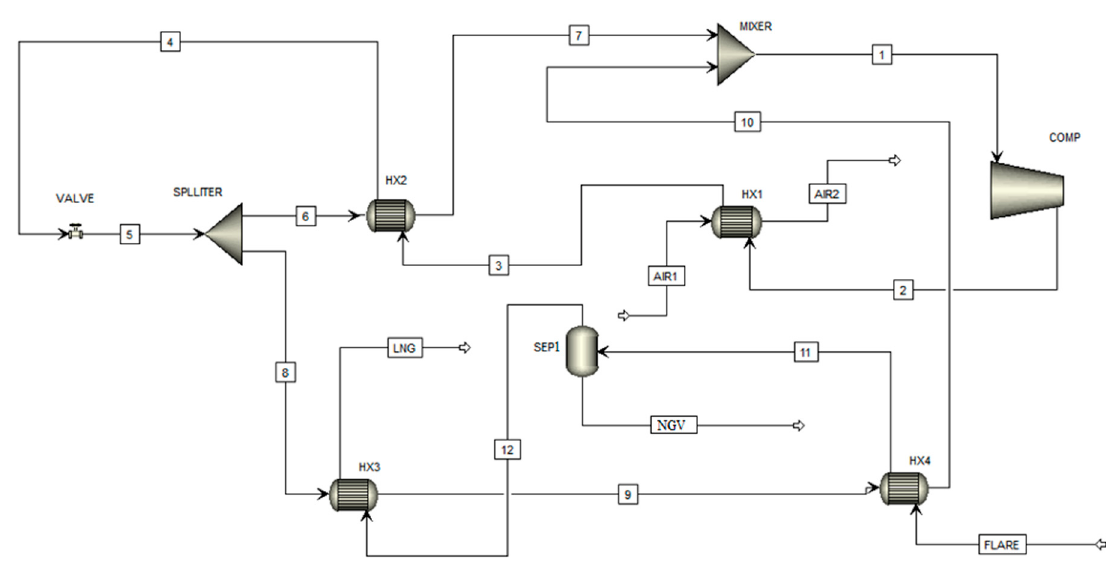
Figure 3. Refrigeration cycle flow diagram of the flare recovery process.